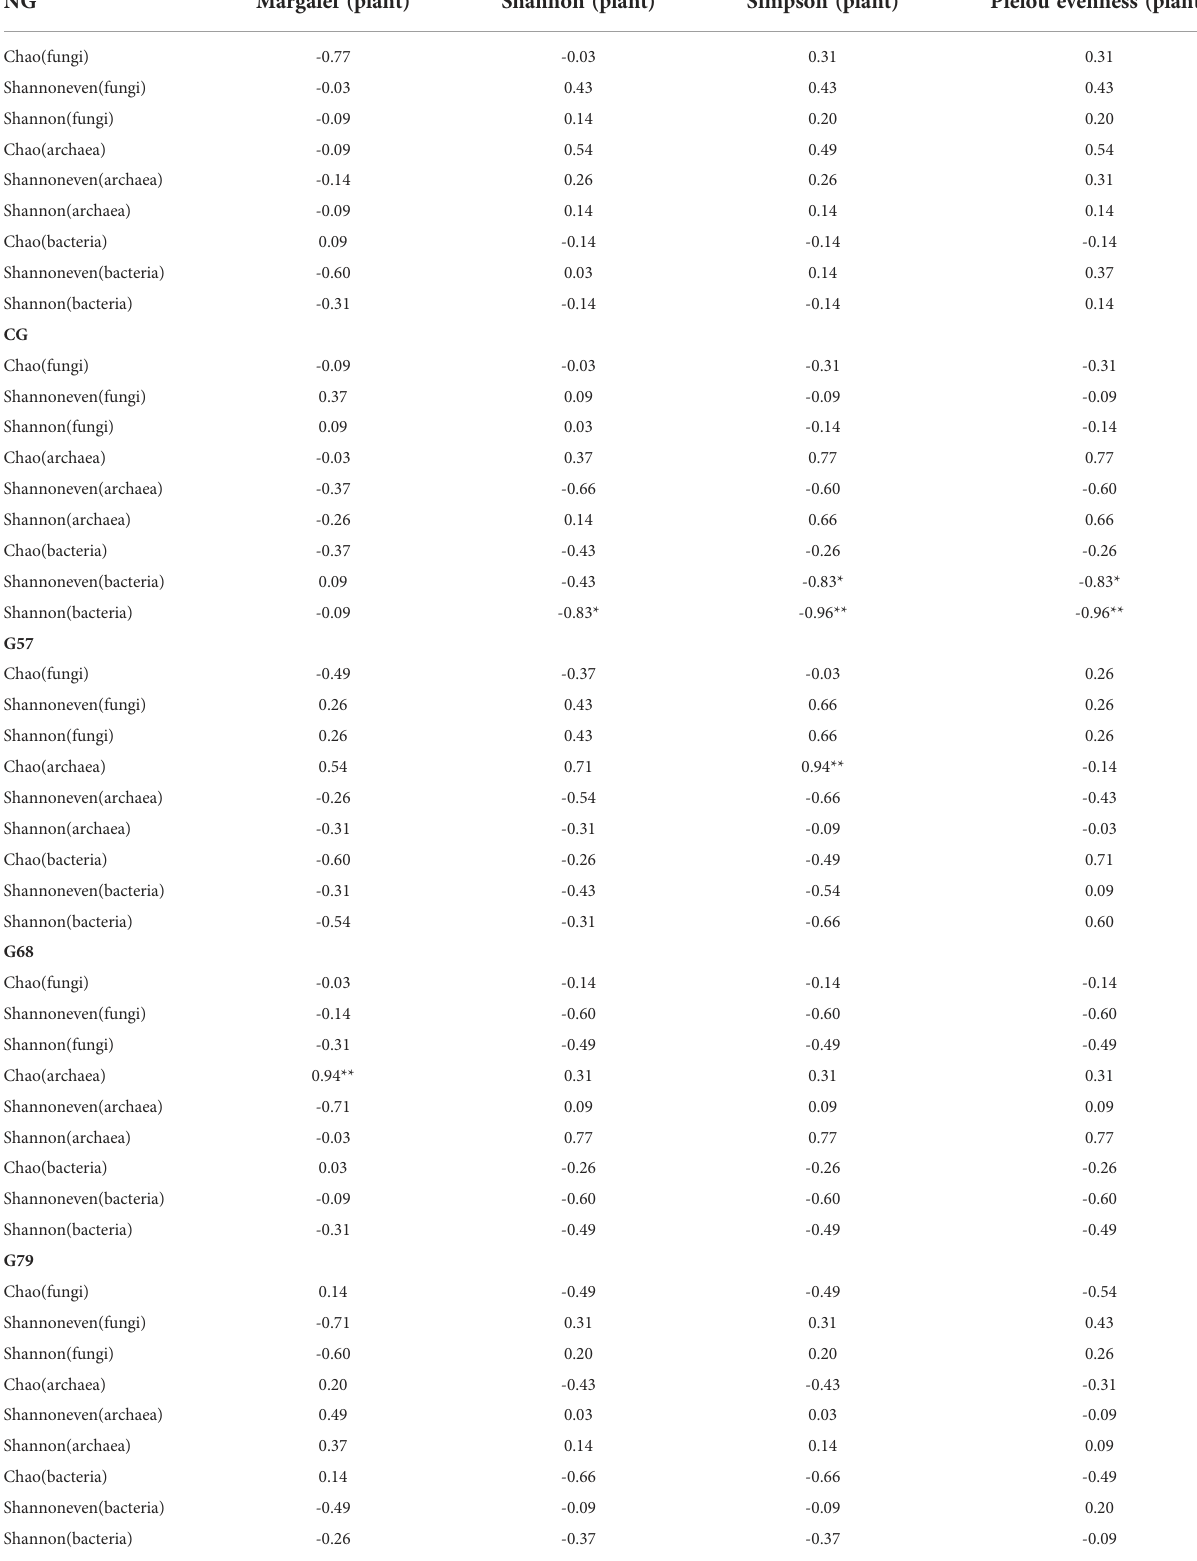
TABLE 1 Correlation analysis between grazing aboveground plants and soil microbial diversity in fi ve grassland management treatments.